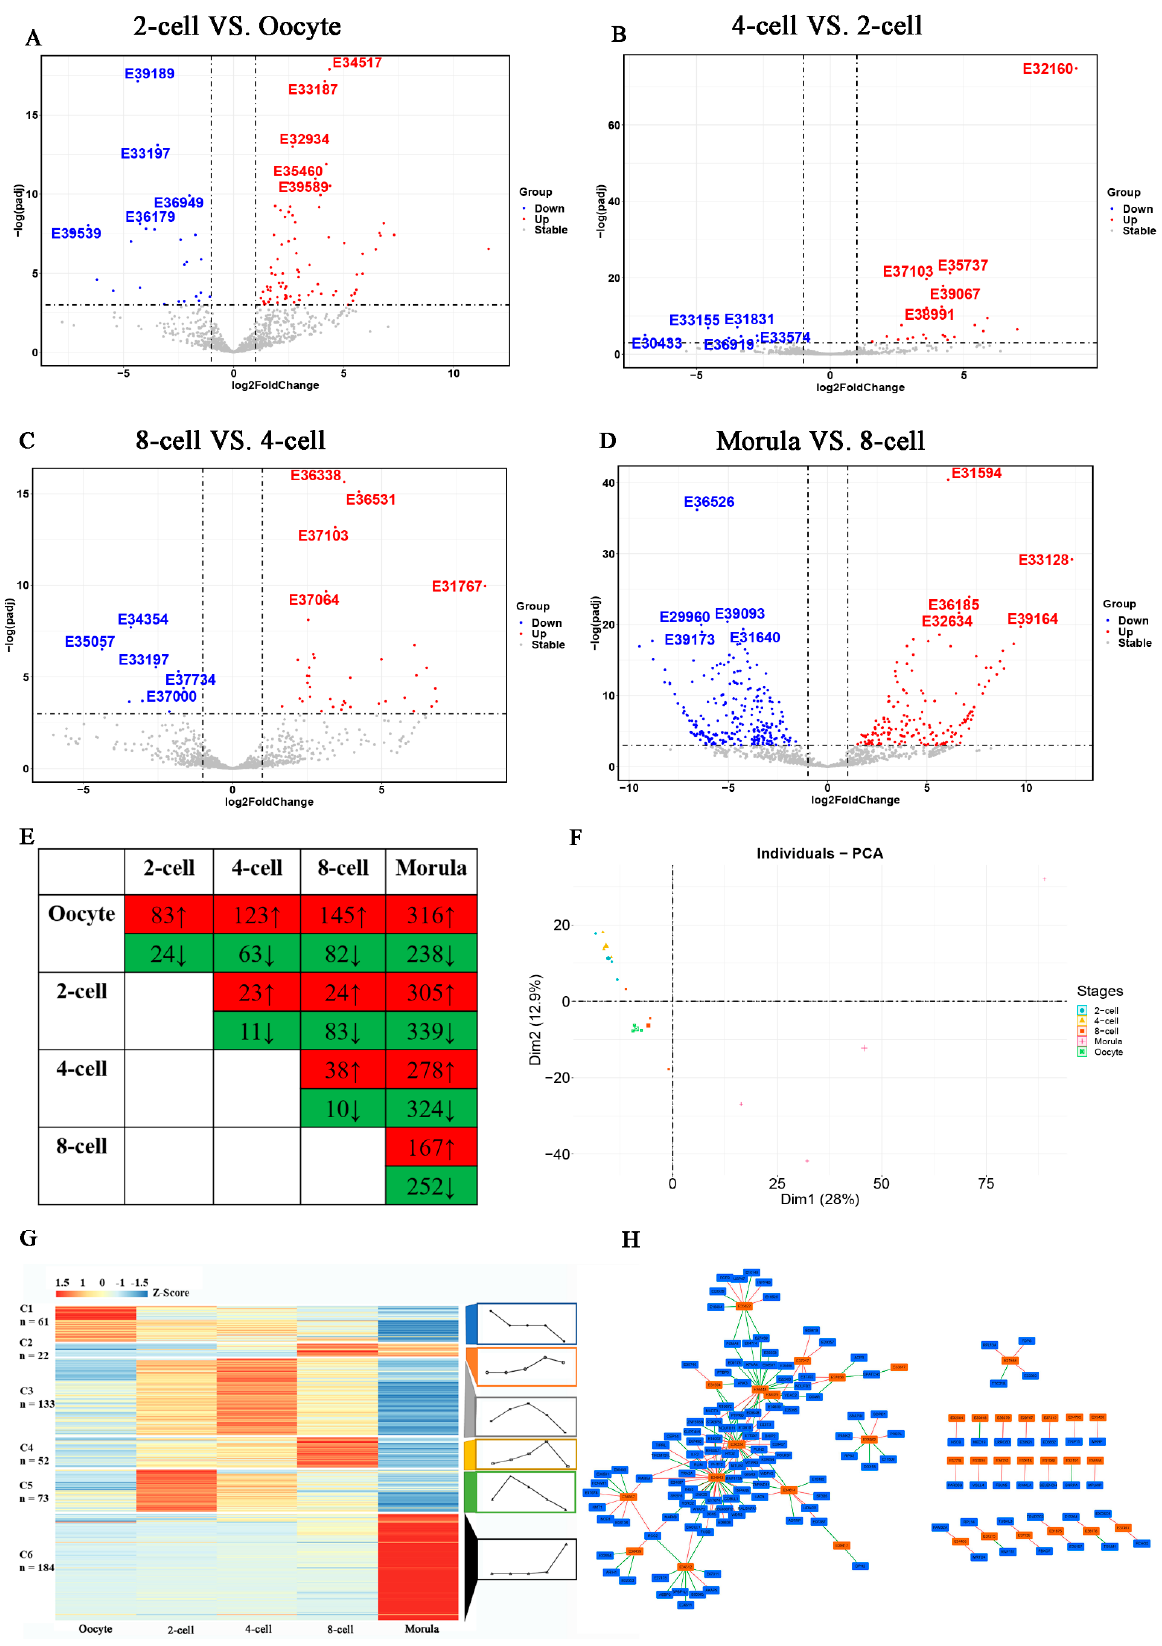
Figure 1. Dynamics of lncRNAs during rabbit pre-implantation development. ( A – D ) DE lncRNAs between consecutive stages: oocyte and 2-cell, 2-cell and 4-cell, 4-cell and 8-cell, 8-cell and morula; log(padj) (logarithm (adjust p -value)).